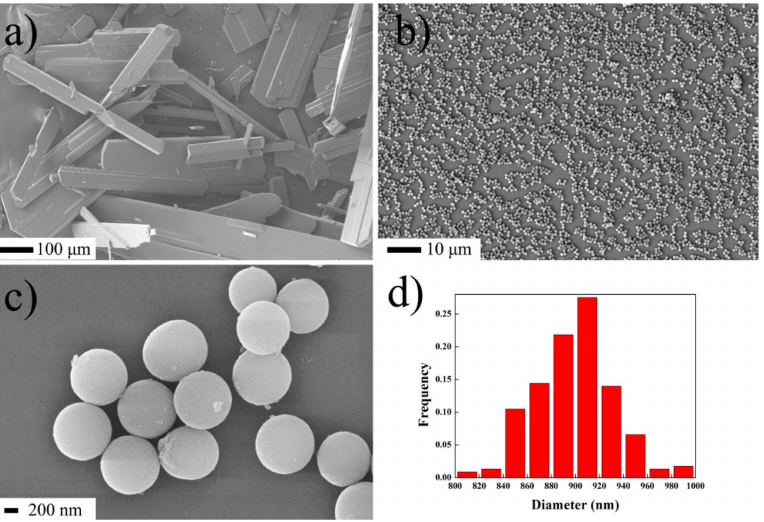
Figure 2. The SEM images of ( a ) raw HNS and ( b , c ) as-prepared samples, ( d ) the particle size distribution of spherical nanoparticles from statistical data by